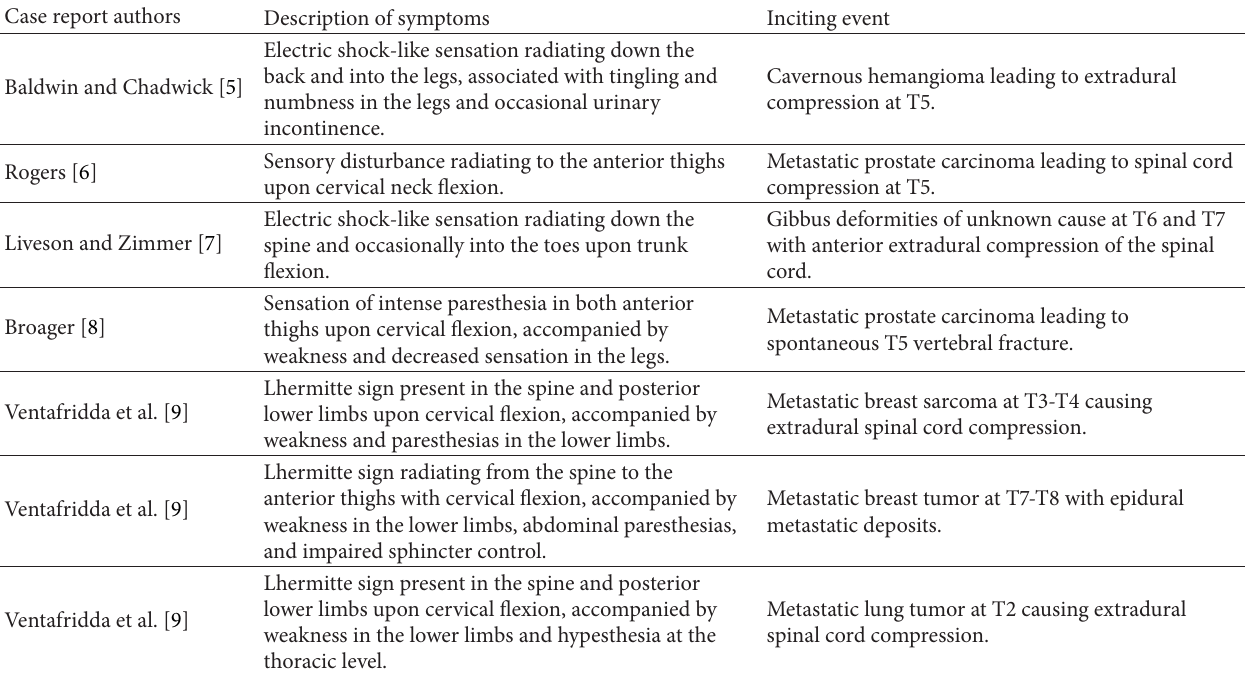
Table 1: Reported cases of Lhermitte sign due to isolated thoracic